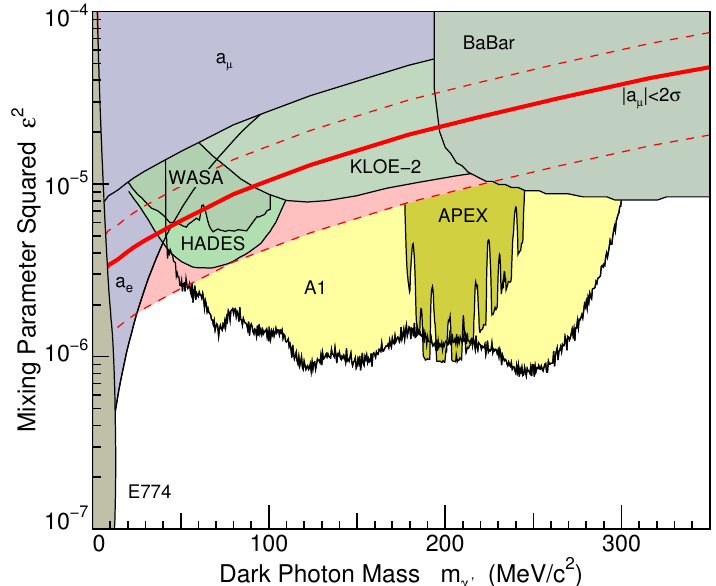
Figure 2. Exclusion limit derived by the A1 experiment. See text for the explanation of the di ff erent lines.